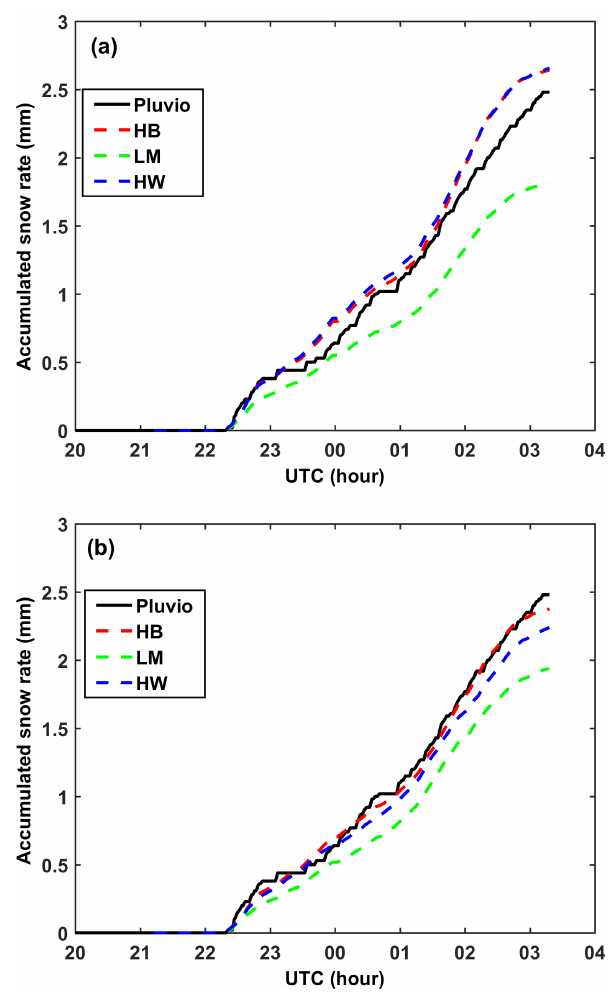
Figure 15. Comparison of the radar-derived accumulated SR us- ing HB, LM, and HW methods with Pluvio gauge measurement. (a) The radar SR is computed by Z Ka –SR relationships. The Pluvio- accumulated SR on 03:18UTC is 2.48mm. The radar-accumulated SRs for HB, LM, and HW are 2.64, 1.81, and 2.66mm. (b) The radar SR is computed by combining SR( Z Ku ,DWR) and Z Ka –SR as described in the text. The accumulated SR derived from the radar using HB method is 2.38mm, using LM it is 1.94mm and using HW it is